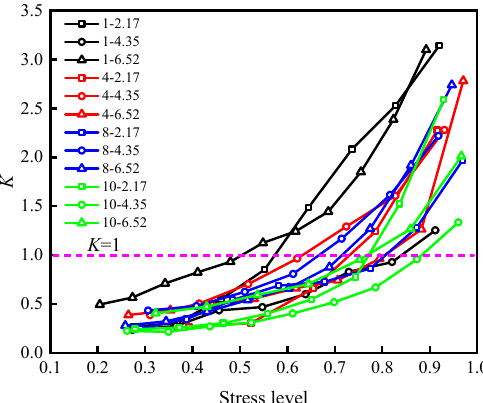
Materials 2022 , 15 , x FOR PEER REVIEW Figure 10. The energy consumption ratio of each sample varies with the stress level.